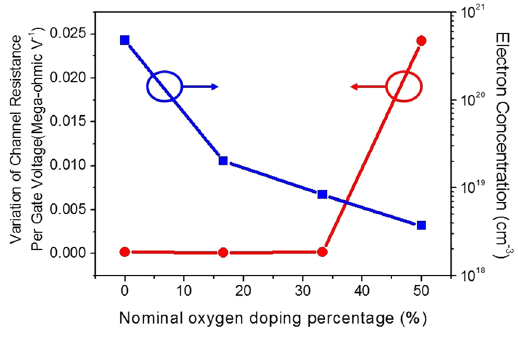
Figure 4. The variation of channel resistance per gate voltage σ R and electron concentration of the 4.8 nm TiN- based ultrathin-body channel as a function of the nominal oxygen doping